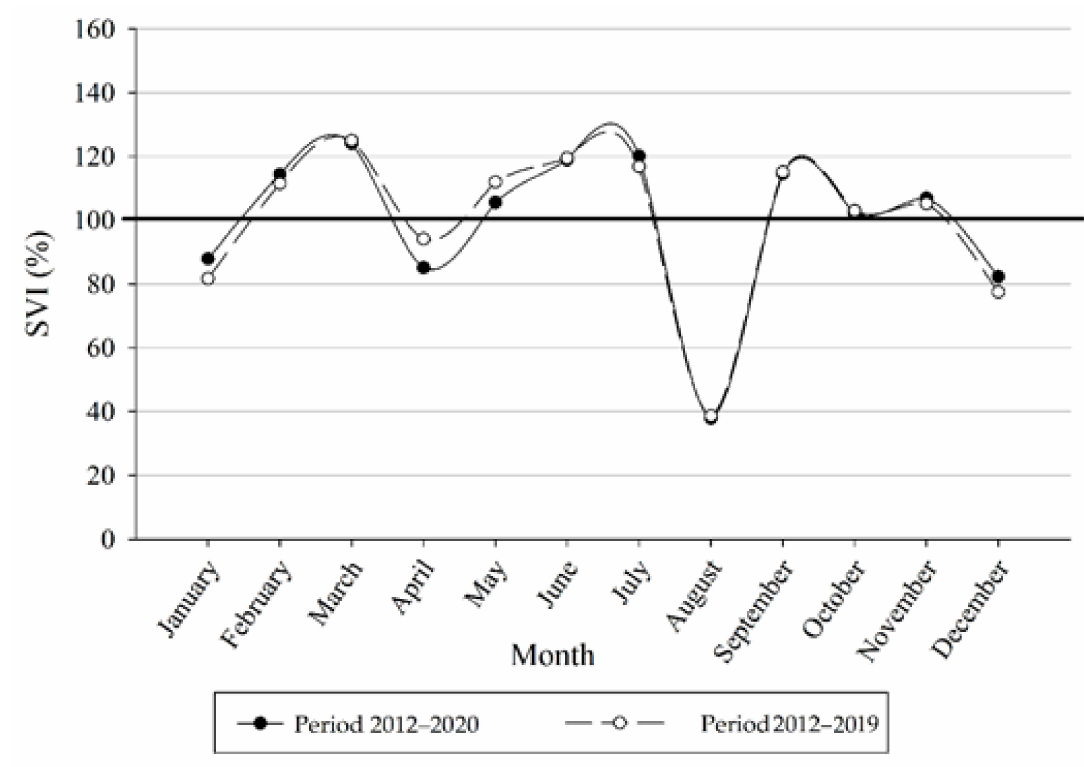
Figure 12. Seasonality pattern of vehicle embarking traffic of the port of Pasajes during the periods 2012–2019 and 2012–2020.